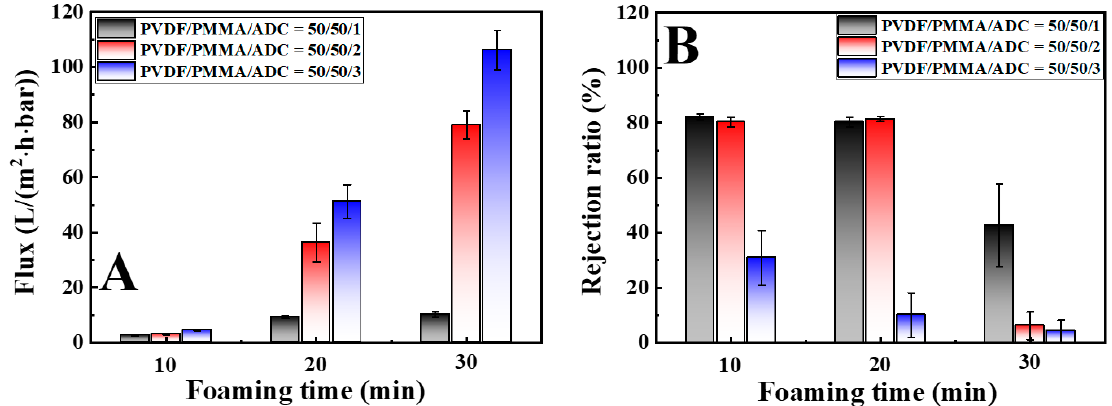
Figure 6. Flux of pure water ( A ) and rejection ratio in the separation of BSA solution ( B ) of various PVDF HPMs.